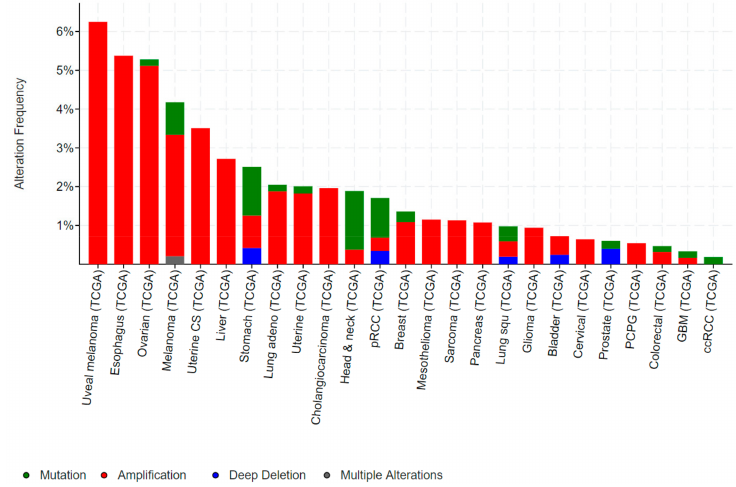
Figure 10. Genomic alterations in SPDEF in human cancers. Data from cancer bioportal. Only showing cancers in which >50 cases were